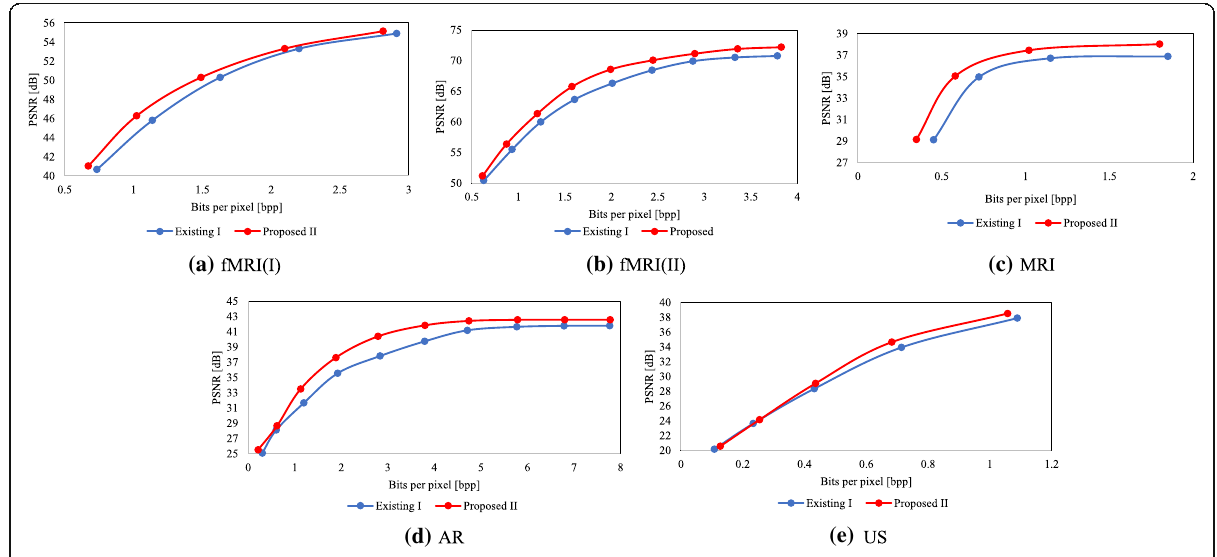
Fig. 20 Coding performance in lossy mode for fMRI(I), fMRI(II), MRI, AR, and US data. a fMRI(I). b fMRI(II). c MRI. d AR. e